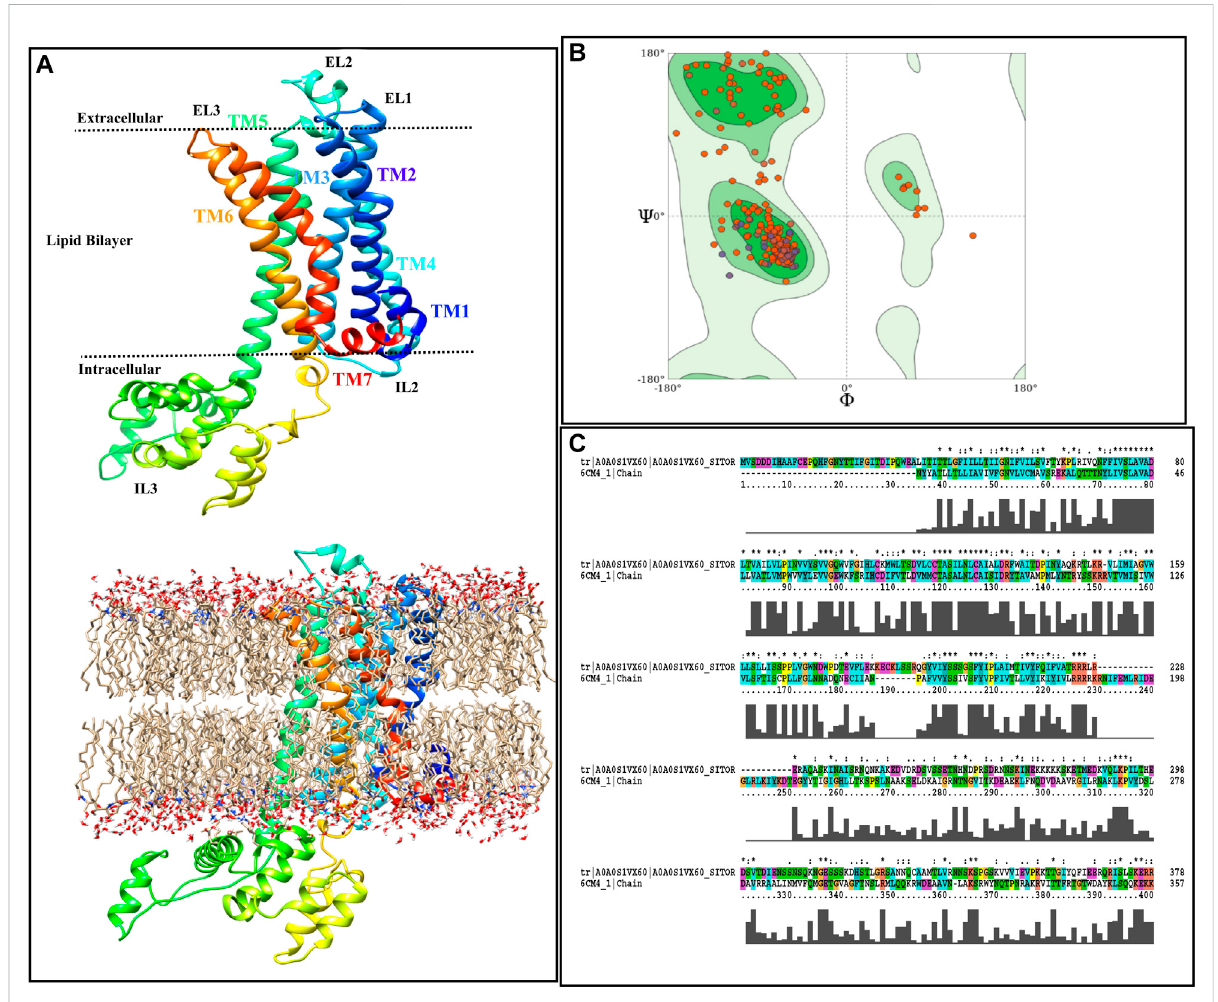
FIGURE 2 Homology modeling procedure of TyrR is shown. (A) The TyrR model describing TM and loop sections and showing the intra/extracellular boundariesoftheproteinlustrationas implicit(top) andexplicit (bottom) lipidbilayer, (B) Ramachandrandiagramispresented tothestereochemical quality of the model made (C) alignment of the target sequence to the dopamine D2 receptor with the CLUSTALX program is